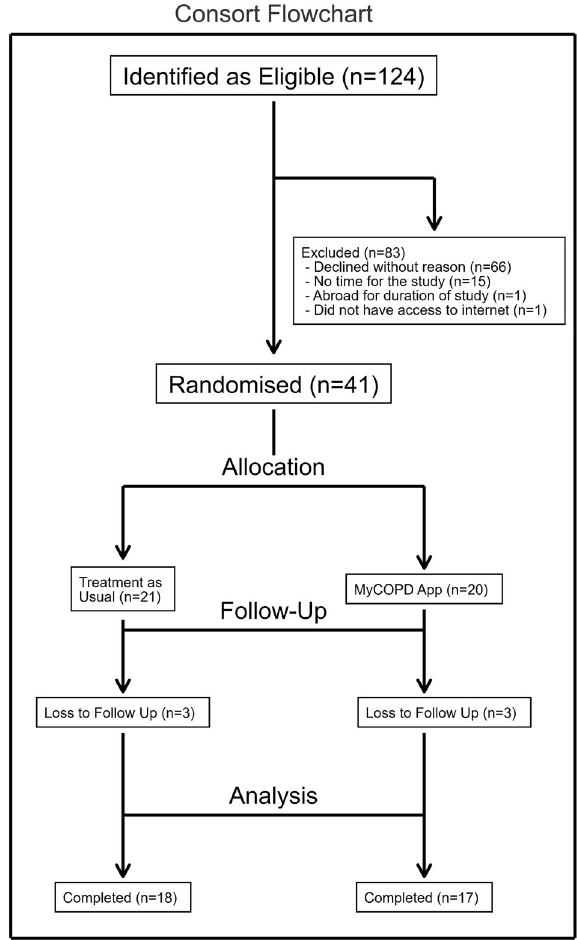
Fig. 1 Flow diagram of study participants. Indicated is the consort fl owchart of study participants through the study. Showing the number of eligible patients, number excluded and reasons for exclusion, number randomised to each arm, number of loses to follow up in each arm and number included in the analysis for each